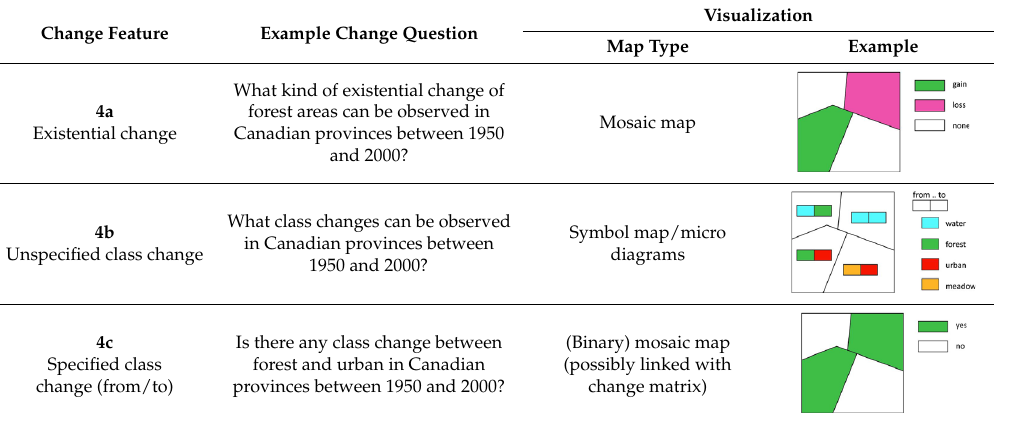
Table 4. Visualization of “What” output clauses (compare classification in Table 1).